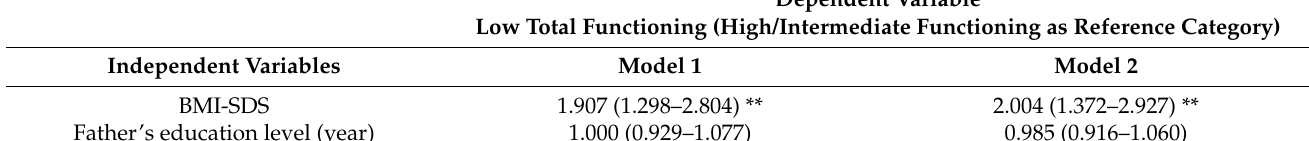
Table 5. Multiple logistic regression analyses of the associations between low total functioning and parents’ or adolescents’ characteristics (high/intermediate functioning was used as reference